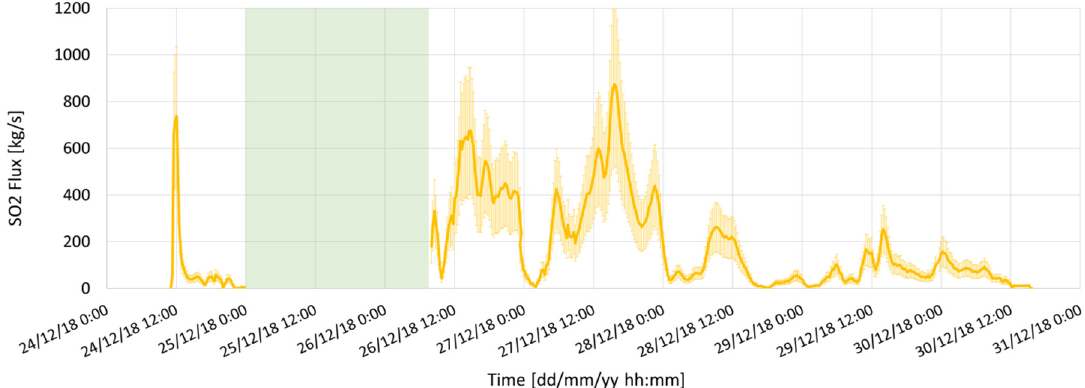
Figure 8. SO 2 flux time series obtained from 15-min SEVIRI images. In green, the time interval that indicates the presence of a meteorological cloud system over the Mediterranean. The yellow vertical bars represent the SEVIRI SO 2 flux retrieval uncertainties.